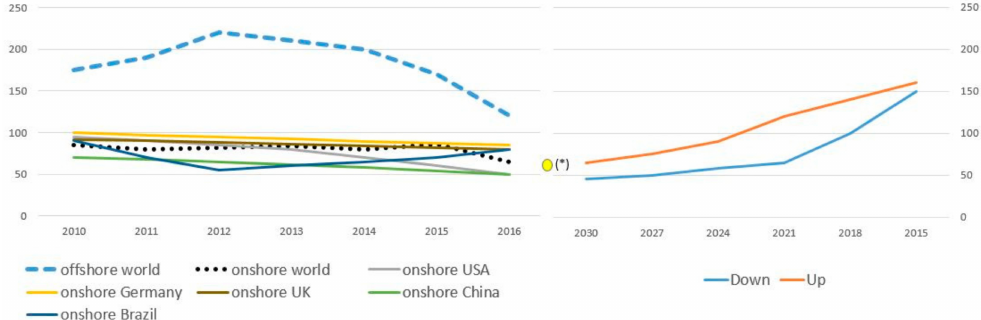
Figure 10. Average onshore levelized cost of energy ( LCOE ) and o ff shore 2010–2016 and o ff shore LCOE estimated for 2015–2030. Source: adapted from IRENA 2018 and Wind Europe 2017 [49,50]. (*) EUR 65 / MWh is considered a competitive LCOE value for o ff shore wind